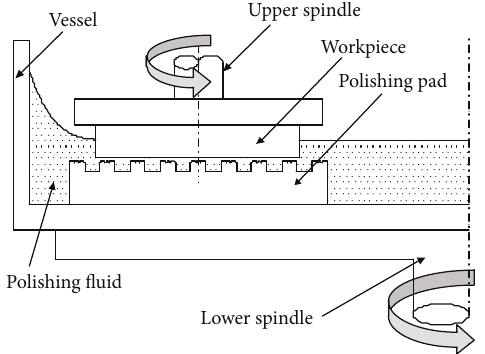
Figure 11: Float polishing principle.